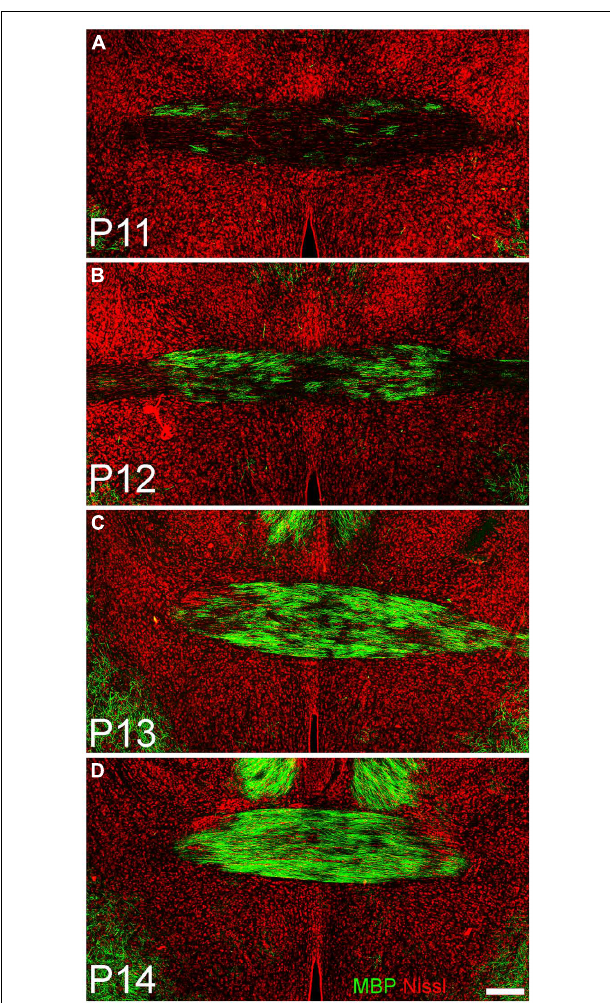
FIGURE 5 | Coronal sections taken through the anterior commissure at P11 (A), P12 (B), P13 (C), and P14 (D). Dorsal to top. A few fibers expressing myelin basic protein (green) can be seen traversing horizontally in the commissure at P11; by 72 h later (D) the region is densely filled. Red = Nissl stain. Scale bar = 200 μ